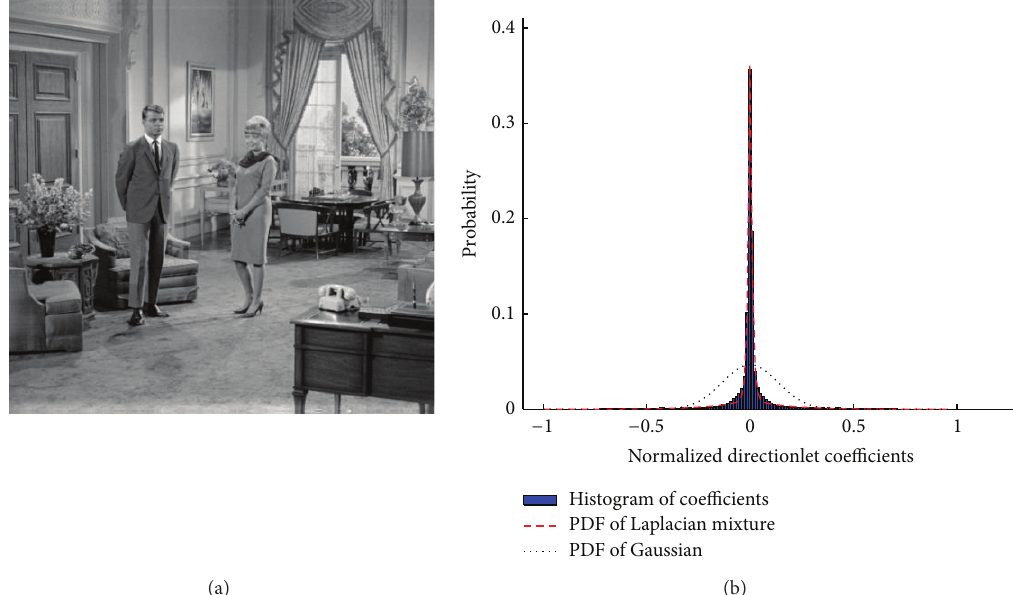
Figure 2: A natural image and its corresponding fitting models in directionlet domain. (a) Couple image. (b) Histogram of the normalized directionlet coefficients for image and the Gaussian and Gaussian mixture PDFs used to model the